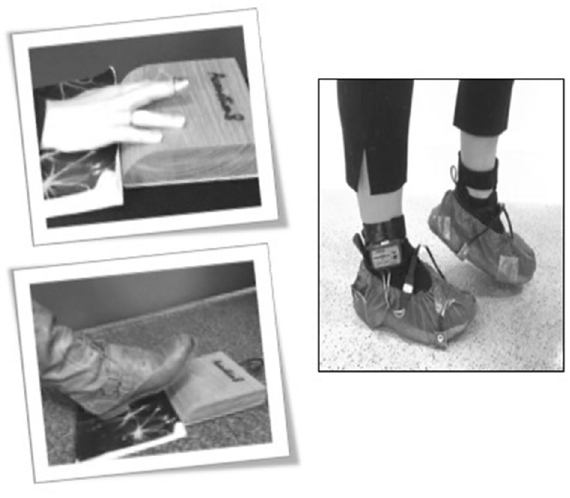
Figure 1. Illustrations of the experimental setup and apparatus for the three task modalities.